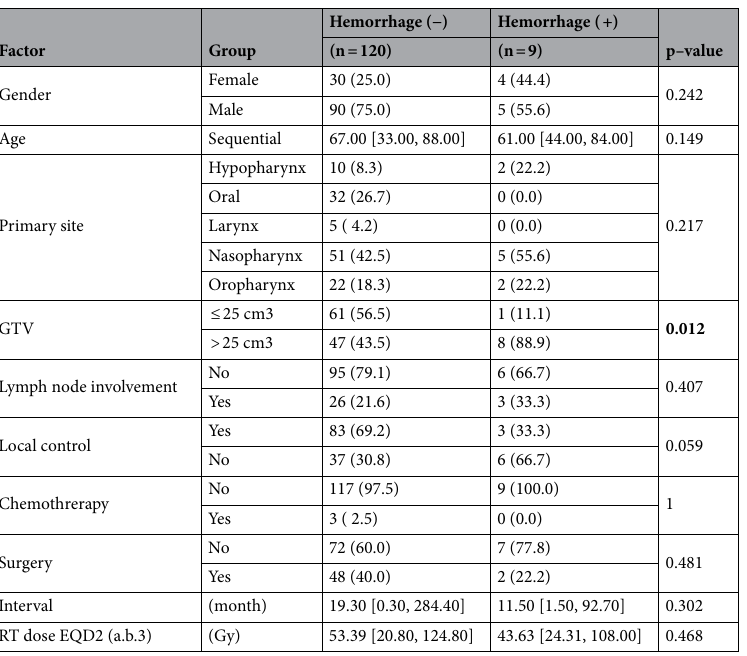
Table 4. Background comparison between patients with or without bleeding. Significant values are in bold.